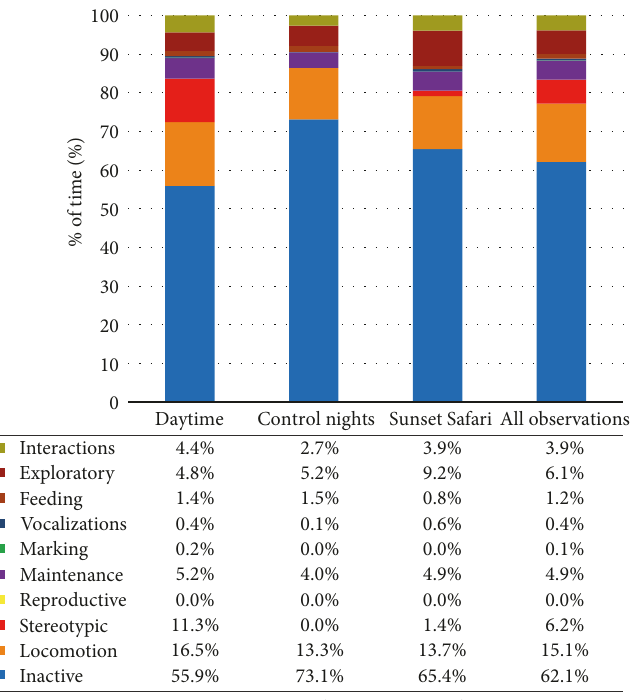
Figure 4: Overall time budgets for each observation period and a complete time budget for all observations at London Zoo. Data values are included to show exact percentages of time for each behavior